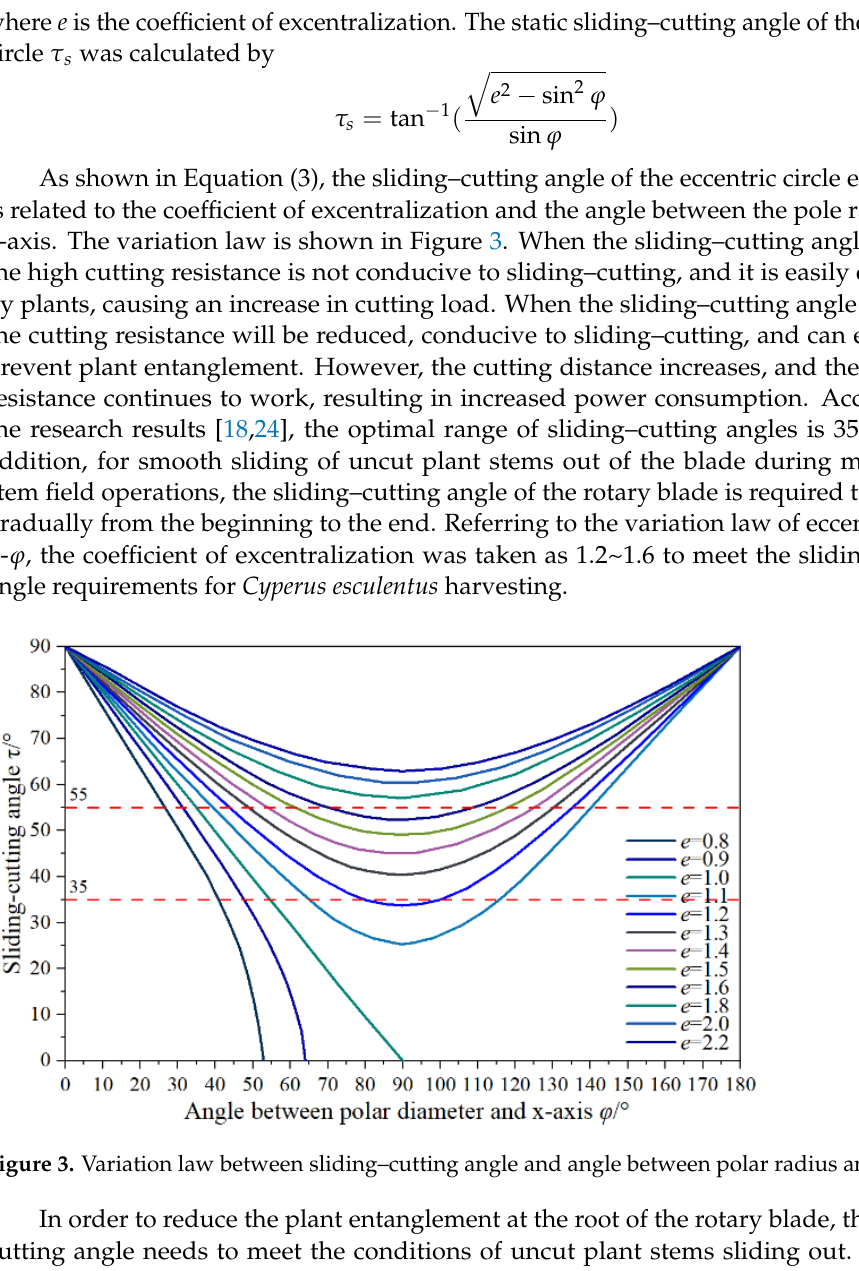
where e is the coefficient of excentralization. The static sliding–cutting angle of the eccentric circle τ s was calculated by